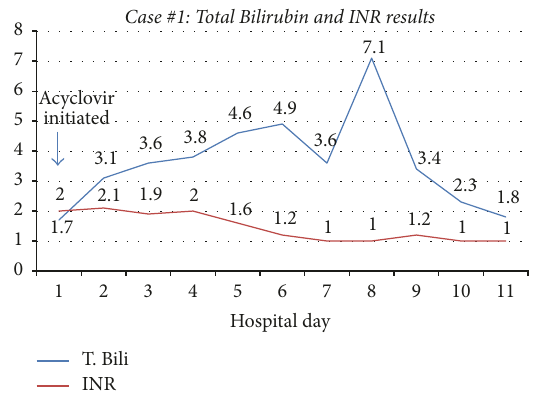
Figure 4: Case #2 trend in Total Bilirubin and INR. T. Bili: Total Bilirubin; INR: International Randomized